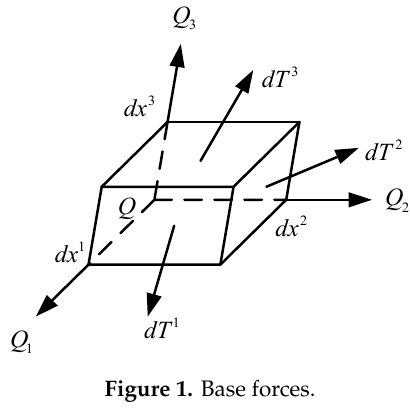
Figure 1. Base Figure 1. Base forces.